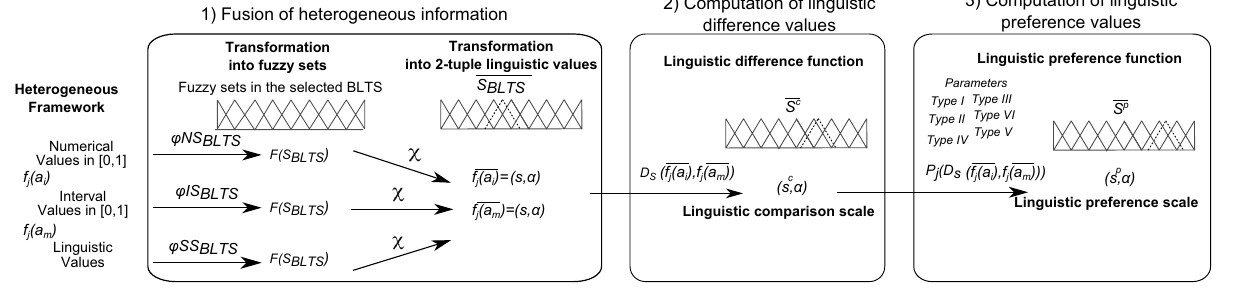
Figure 2: Methodology for modeling linguistic preference